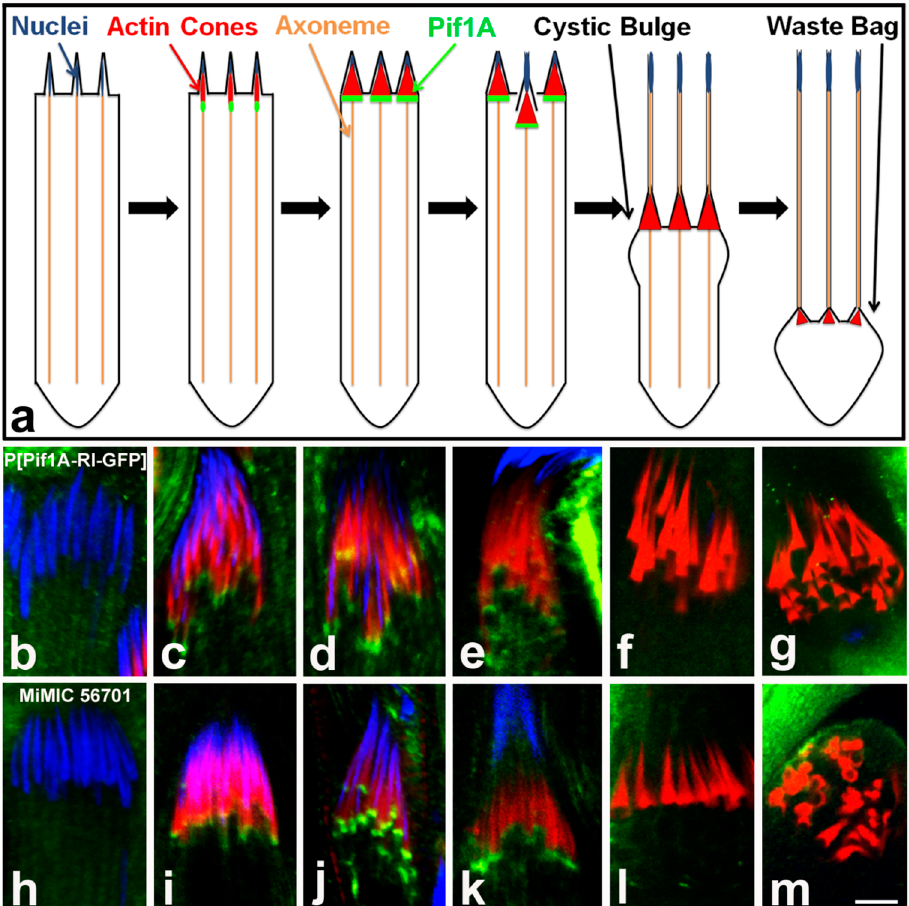
Figure 10. Pif1A localization time series. Schematic of localization of Pif1A protein throughout spermatid individualization ( a ); Pif1A (green) is present in the front region of nascent needle-shaped actin cones and is not observed in individualized cones. Representative homozygote P[Pif1A-RI-GFP] individualization complexes ( b – g ) stained with DAPI (blue), phalloidin/actin (red) and Pif1A-GFP (green) and representative MiMIC-GFP cones ( h – m ) stained the same way—localization profile is consistent with homozygote Pif1A-GFP transgenic cones. Bar 5 µm.